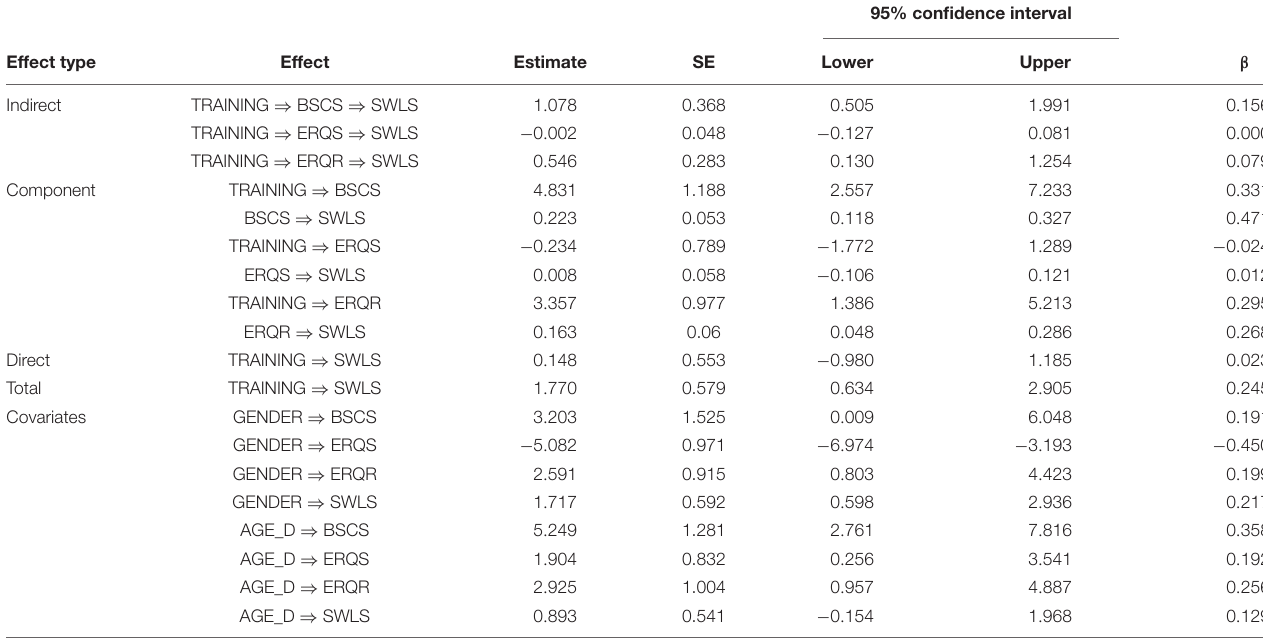
TABLE 3 | Indirect, direct, and total effects of karate training on satisfaction with life in regression-based mediation analysis with self-control, suppression, and reappraisal as mediating variables, and with gender and dichotomized age as